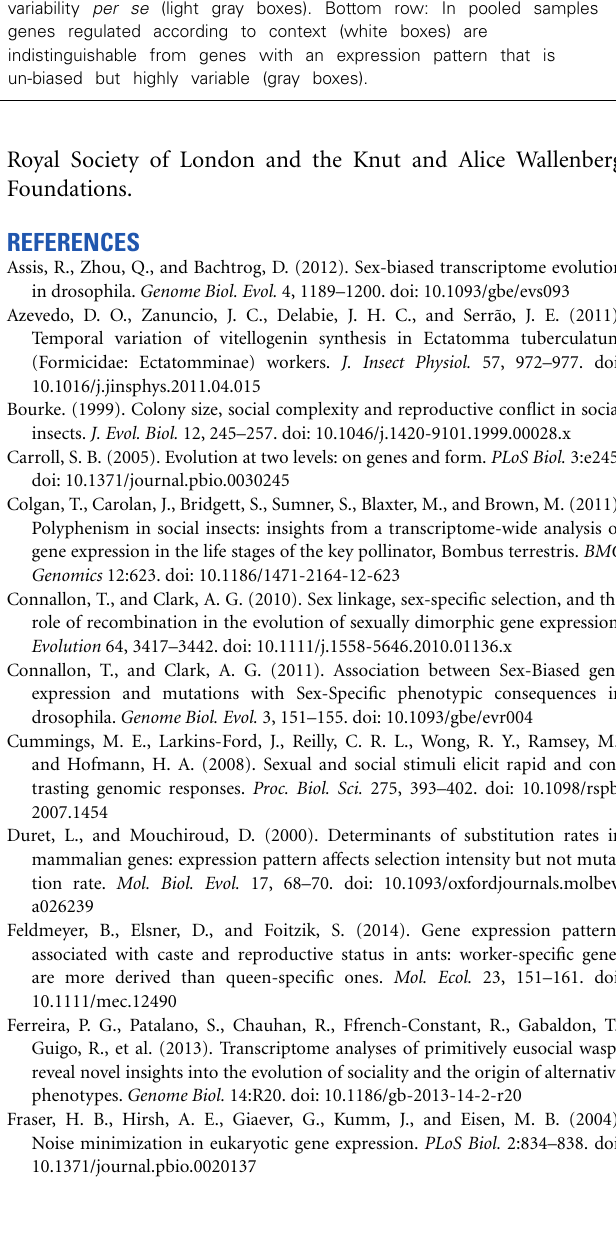
biased pattern. In contrast, pooling samples across contexts makes context-dependent expression indistinguishable from expression variability per se (light gray boxes). Bottom row: In pooled samples genes regulated according to context (white boxes) are indistinguishable from genes with an expression pattern that is un-biased but highly variable (gray